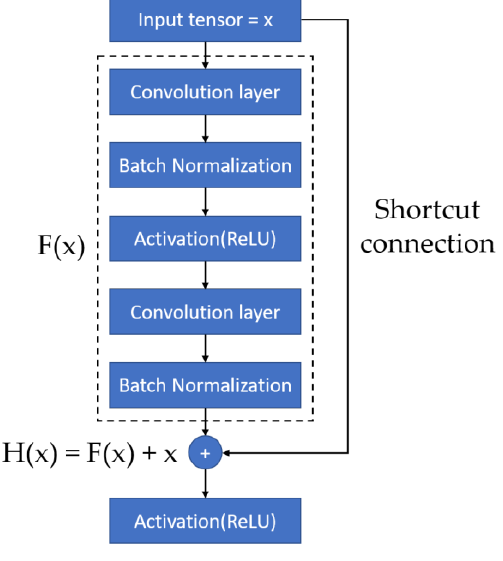
Figure 2. Residual Block [41].